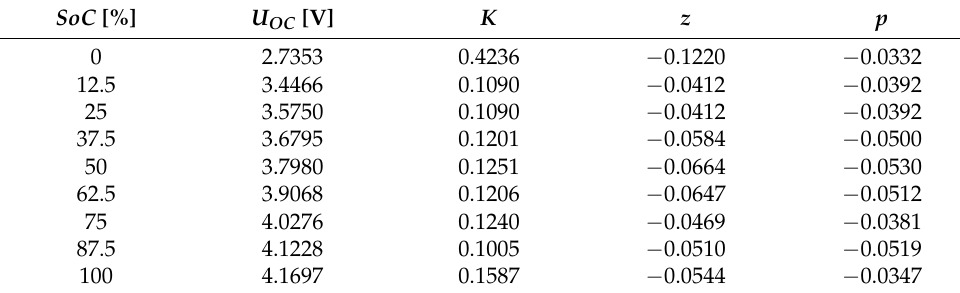
Table 2. Reference table of learned values.